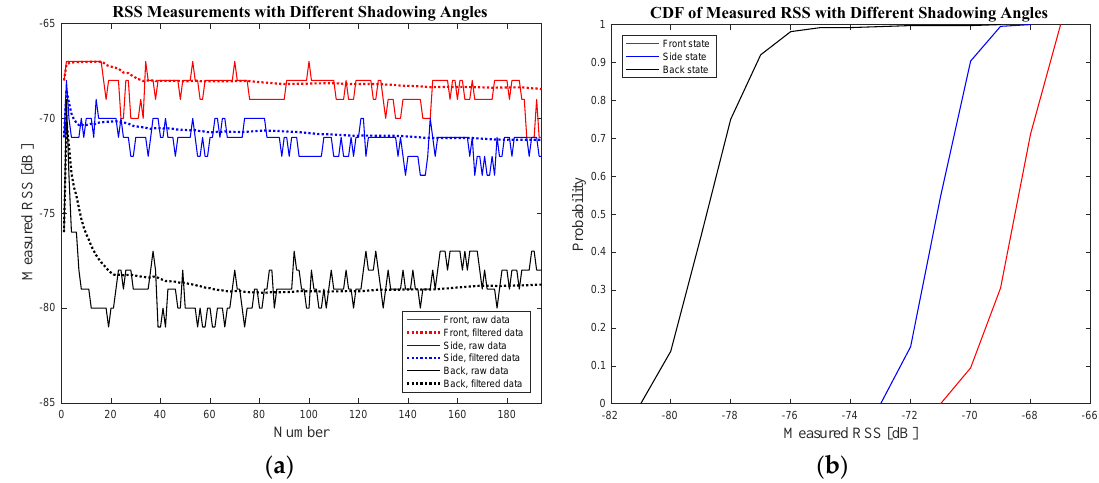
Figure 11. The RSS data for AP9–UP pair at a distance of 3 m for three shadowing angles: ( a ) the original measured RSS data and the filtered data through Kalman filter for the three angle states; ( b ) the Cumulative Distribution Function (CDF) of the measured RSS data for the three angle states.